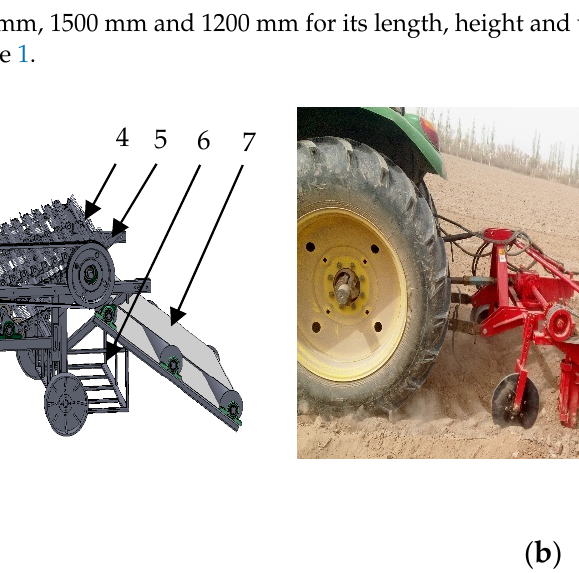
Figure 1. Designed model ( a ) and prototype ( b ) of the PF debris collector, consisting of the following functional parts: soil shovel (1), suspension frame (2), power transmission system (3), conveying device of chains and elastic teeth (4), frame of the PF collector (5), PF recycling box (6) and device for separating residual PF from soil and impurities (7).